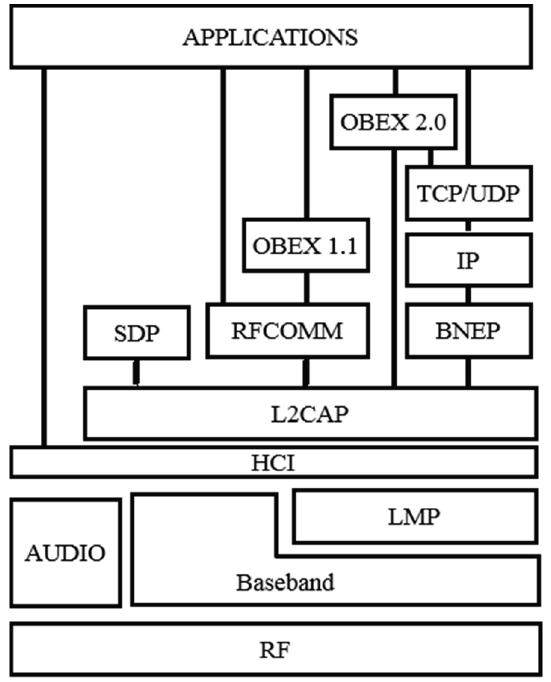
Figure 2. Bluetooth stack